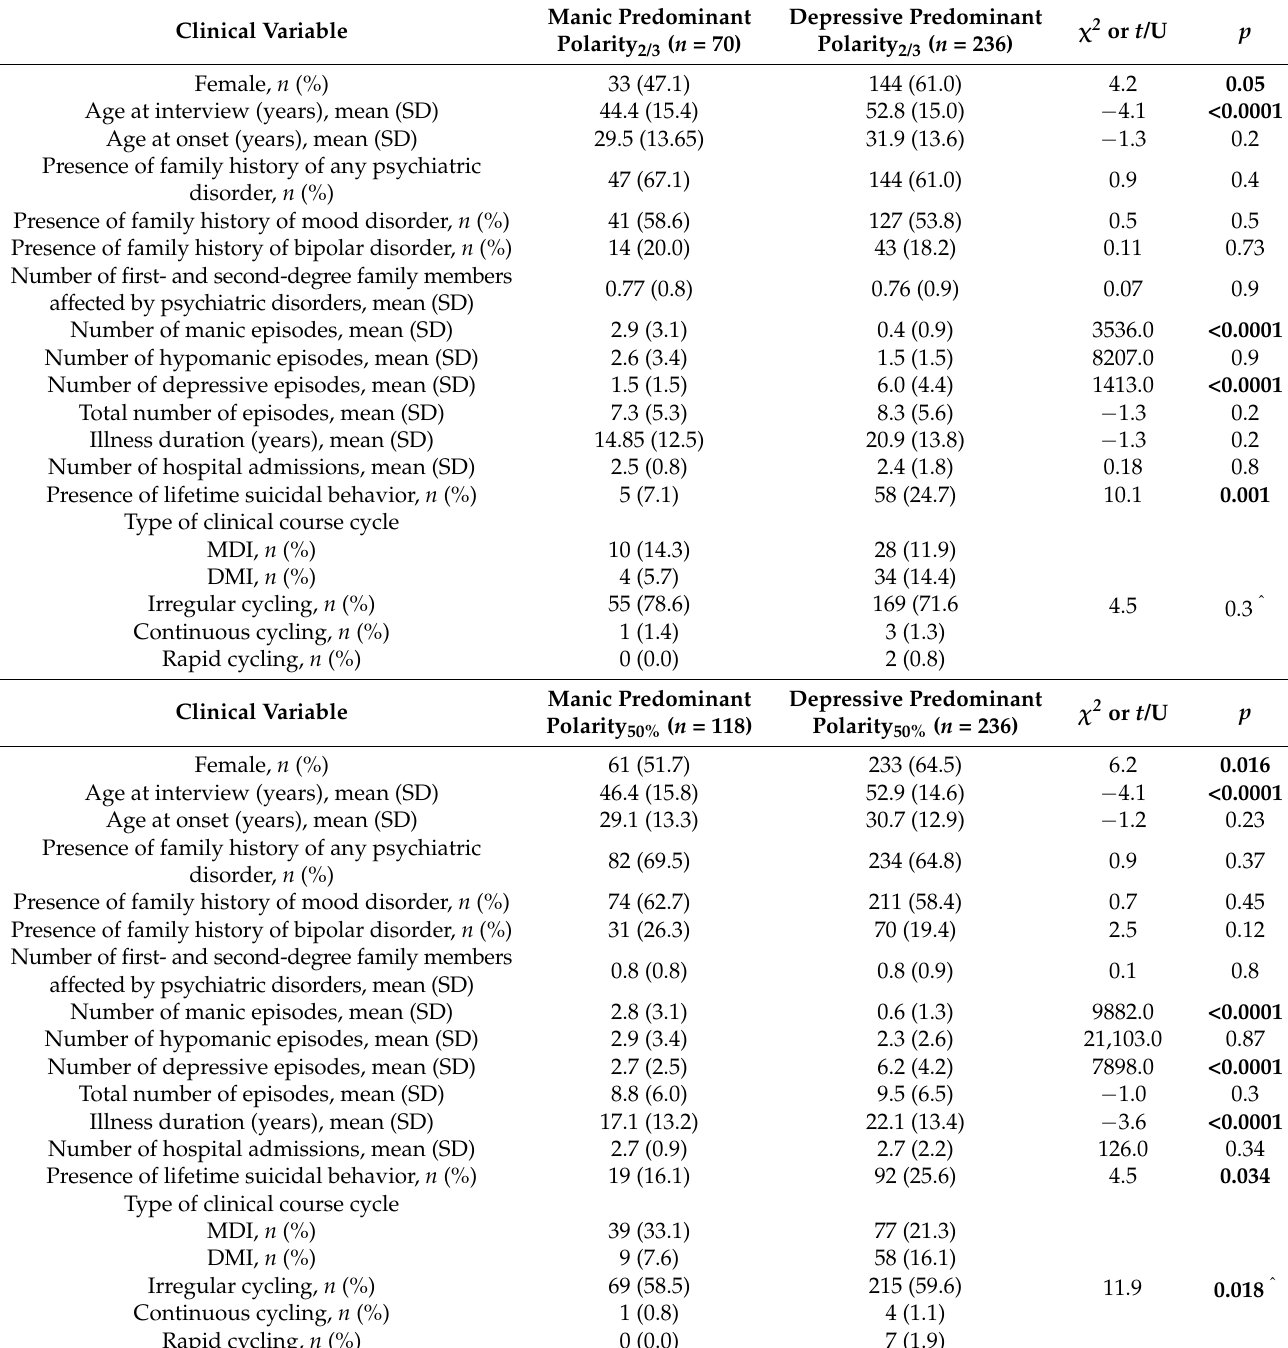
Table 2. Comparison of clinical correlates between manic predominant polarity and depressive predominant polarity bipolar disorder